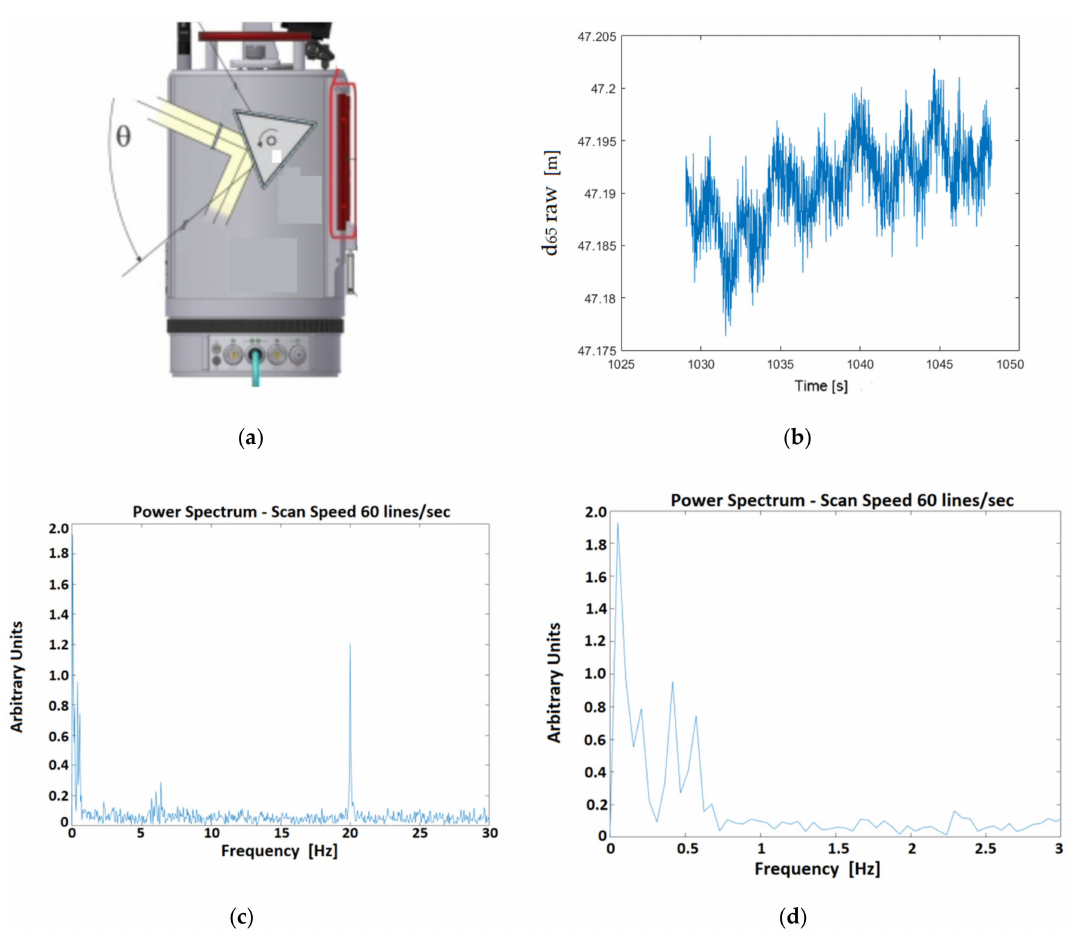
Figure 16. The scheme of rotating mirror of VZ1000 TLS ( a ). Ground distance from TLS of a point 65 m high on the tower base during the acquisition with scan speed 60 Hz ( b ). Power Spectrum obtained by FFT for the ground distance from TLS ( c ). Enlargement of Figure 16c ( d